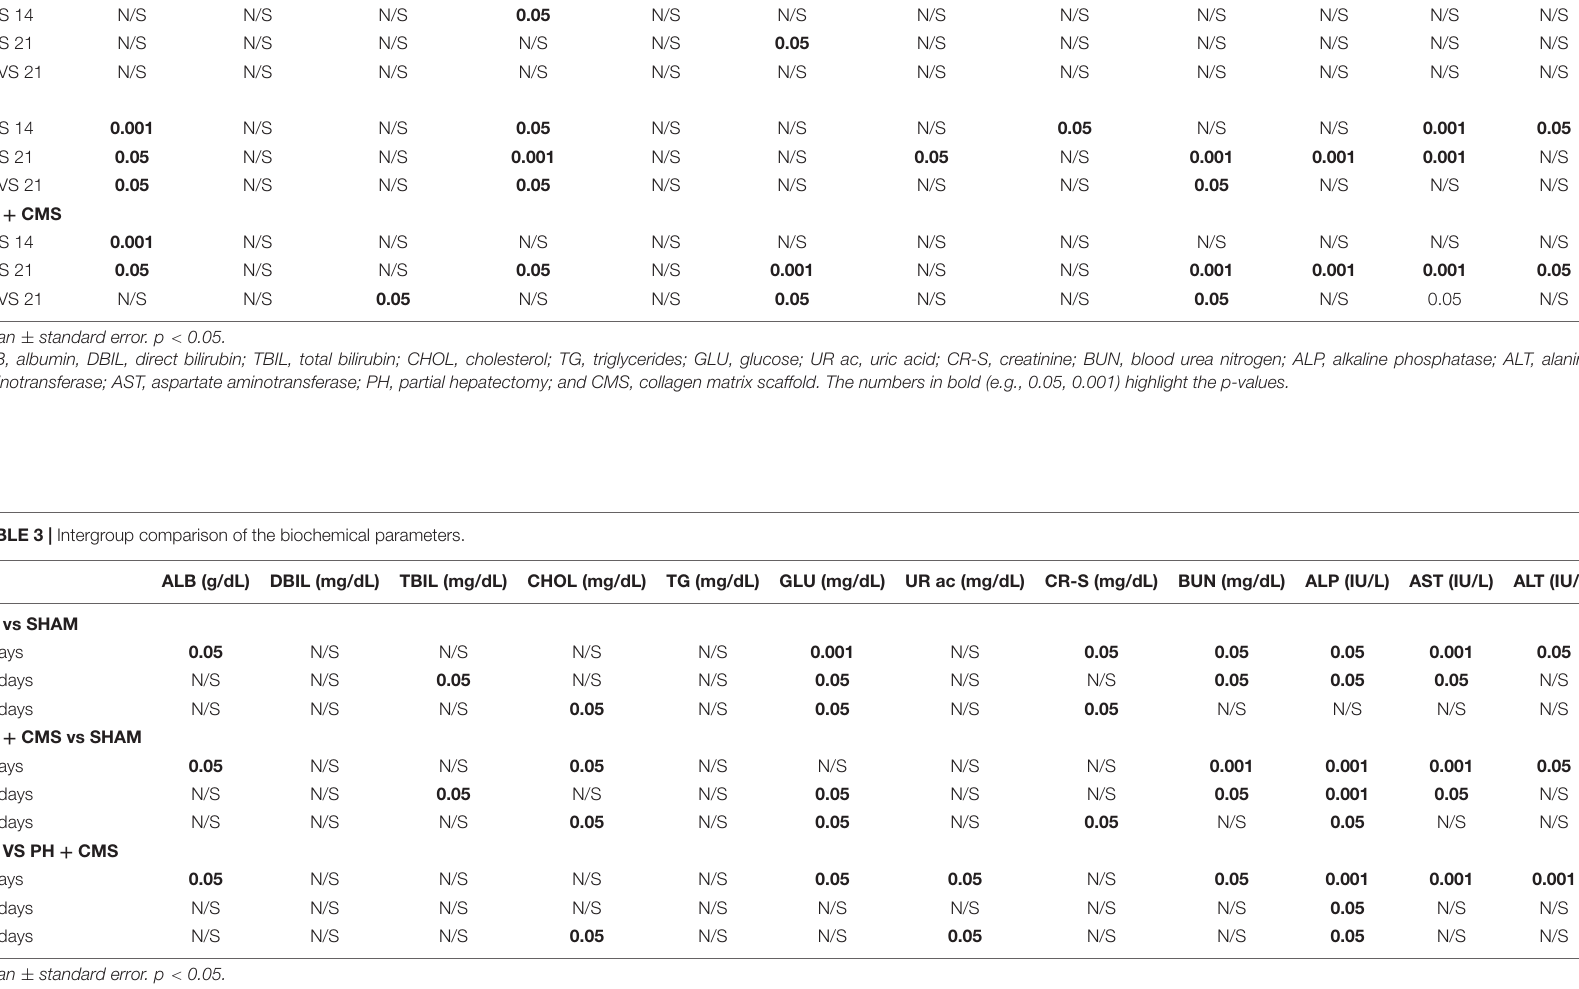
Mean ± standard error. p < 0.05. ALB, albumin, DBIL, direct bilirubin; TBIL, total bilirubin; CHOL, cholesterol; TG, triglycerides; GLU, glucose; UR ac, uric acid; CR-S, creatinine; BUN, blood urea nitrogen; ALP, alkaline phosphatase; ALT,